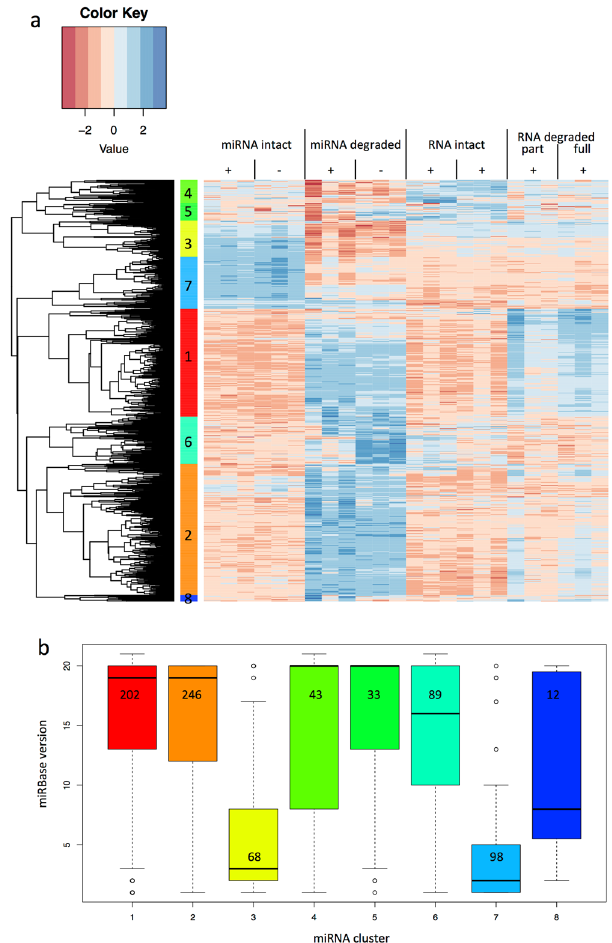
Figure 5. Influence of degradation and RNA isolation methods on miRNA detection using microarrays. ( a ) Unsupervised hierarchical clustering of miRNAs using Eucledian distance and complete linkage in the samples. The treatment and the source of RNA are indicated above the heatmap (see Fig. 1). “miRNA intact” stands for RNA including small RNA isolated from fresh liver tissue, “miRNA degraded” for RNA including small RNA from liver tissue stored for 96 h at RT, “RNA intact” for RNA depleted of small RNA from fresh tissue, and “RNA degraded” for RNA depleted of small RNA molecules and degraded by different concentrations of RNase. “ + / − ” indicating presence or absence of DNase digestion during RNA isolation. The expression of miRNAs in the heatmap are color coded with blue indicating high and red low expression. MiRNAs cluster according to their expression in eight clusters marked with colored boxes and numbers 1 to 8 on the left side of the heatmap. A list of the miRNAs belonging to each cluster is given in Supplementary Table S3. ( b ) Relationship between miRBase deposition of miRNAs and their clustering according to degradation. The eight miRNA cluster as determined in Fig. 4a are listed on the X-axis with the same color code as above. The box-plot shows miRBase version, in which the miRNAs in the respective clusters were first annotated. The numbers of miRNAs in each cluster are given in the respective boxes. The miRBase version is given on the Y-axis (i.e.